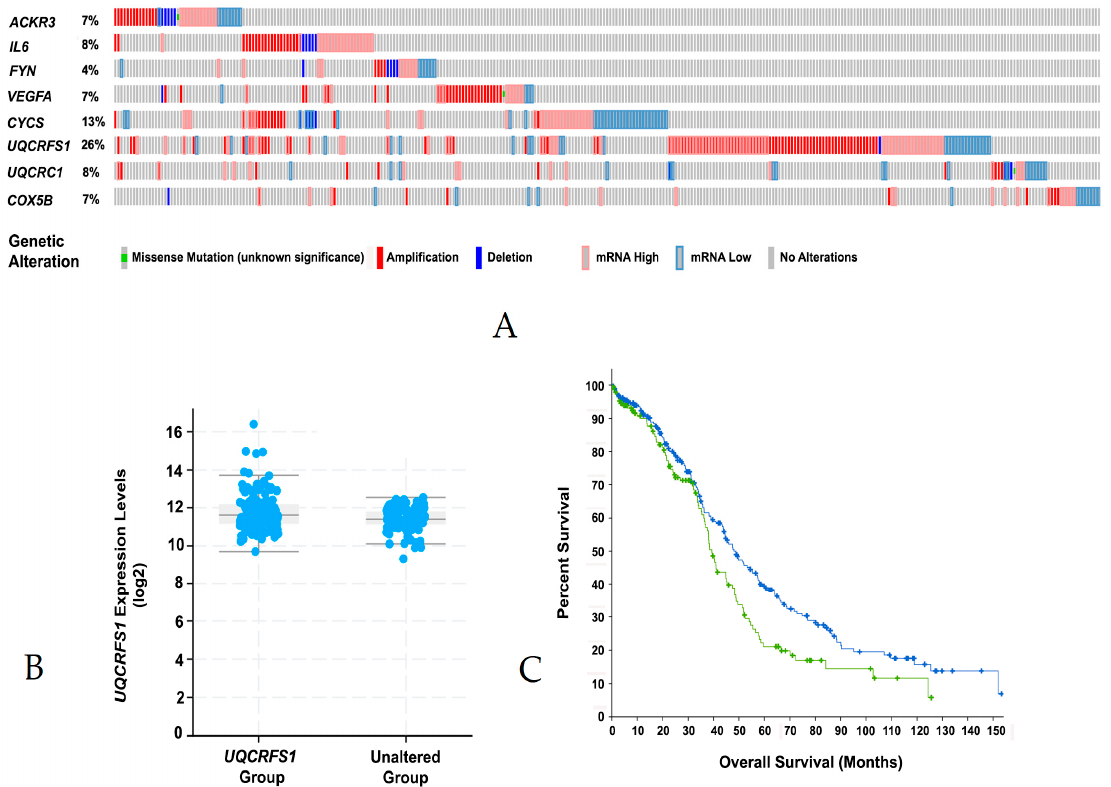
Figure 4. Genomic and expression profile of hub and bottleneck genes in Ovarian cancer patients. Genomic and expression profiles of the hub and bottleneck genes in ovarian cancer patients were visualized in OncoPrint at cBioPortal web-portal ( A ). Plots depicting the expression of the hub node gene UQCRFS1 with the p -value of 2.54e − 8 were obtained from the CBioPortal ( B ). Overall survival of patients with UQCRFS1 amplification or overexpression (Log Rank Test p -value of 3.9e − 2) was extracted from the CBioPortal ( C ).